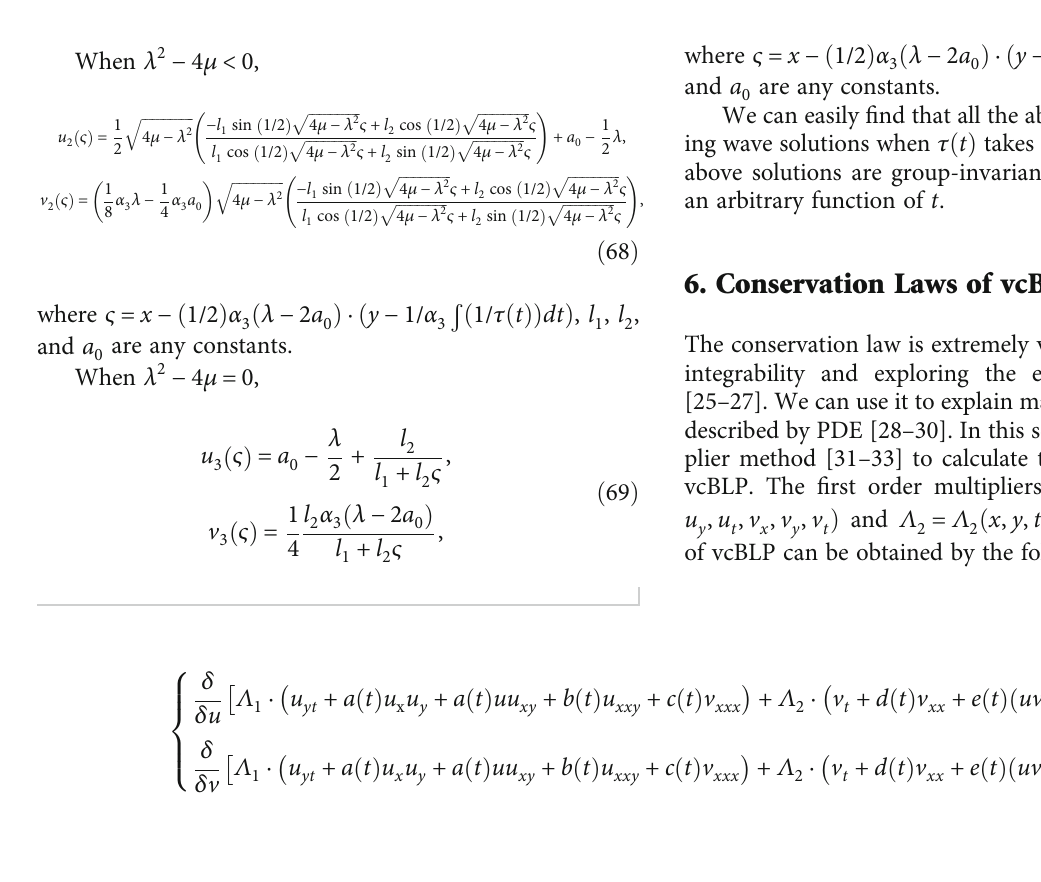
Figure 1: Evolution of Equation (61) at (a) t = 10 − 1 , (b) t = 10 2 , and (c) t = 10 5 . (d) Contour